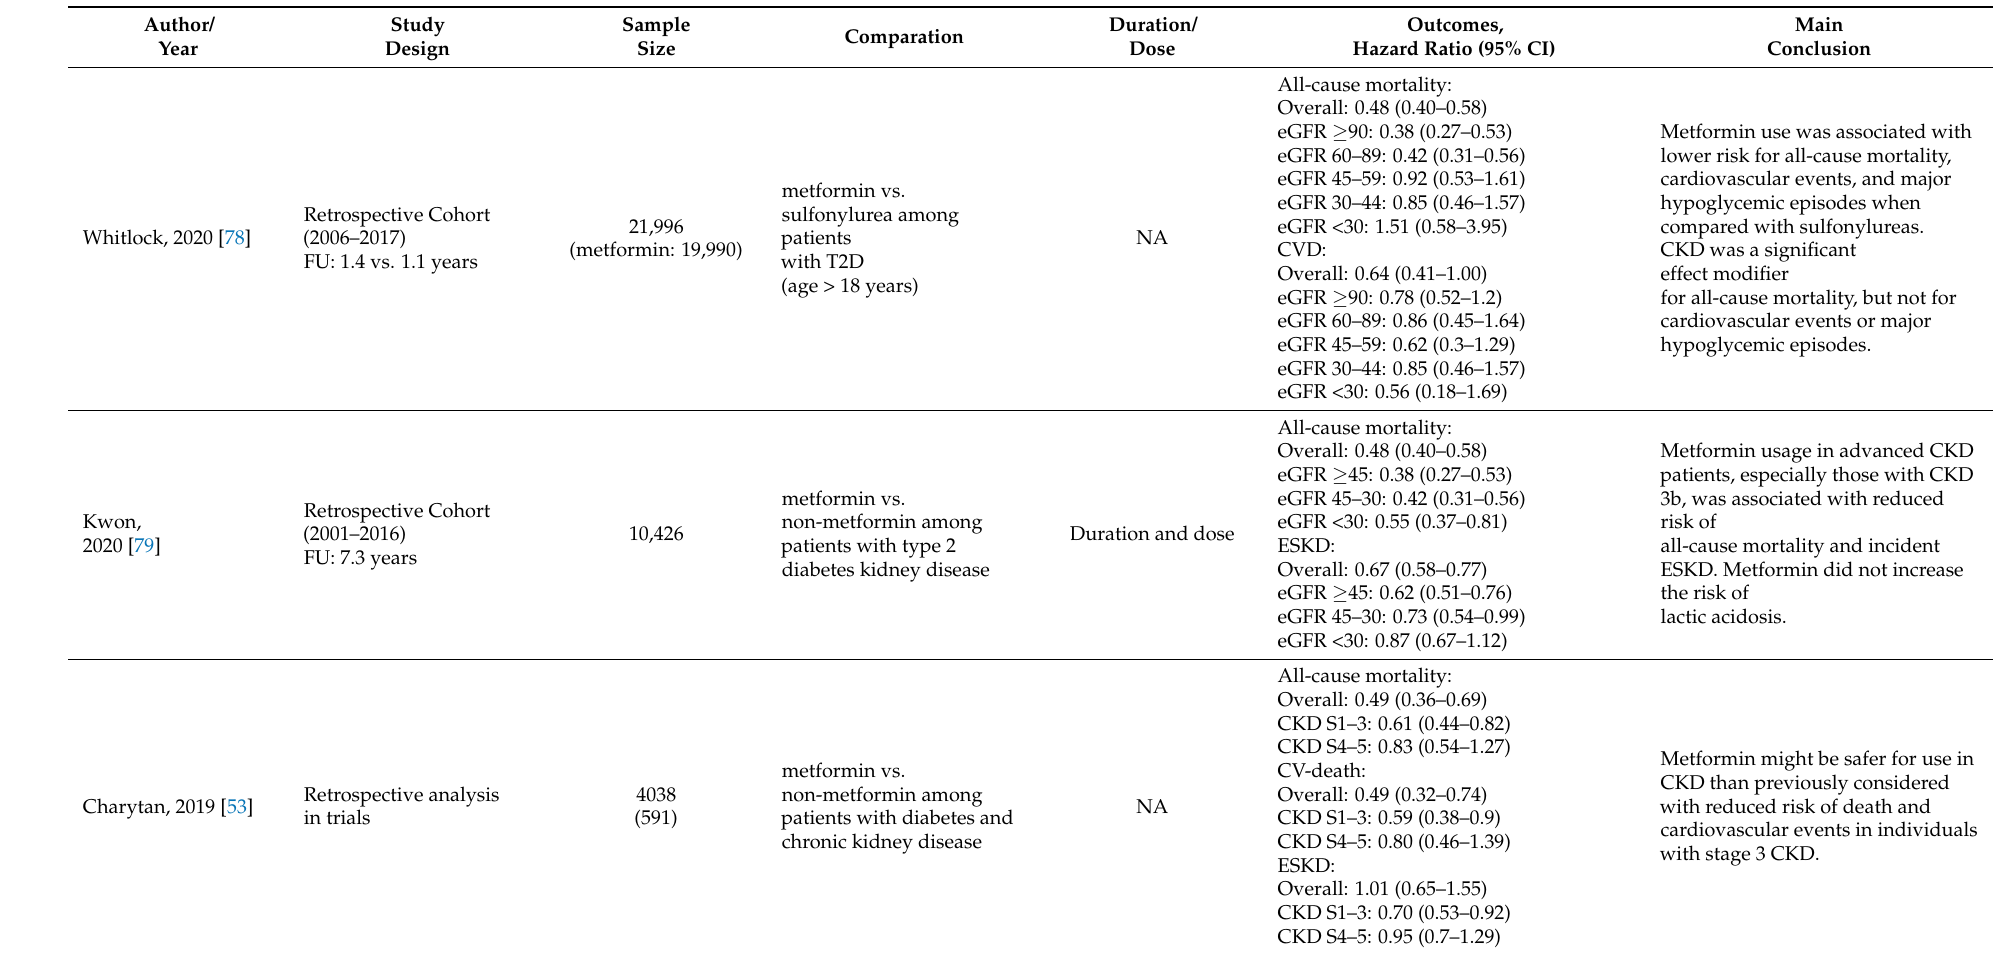
Table 2. Cohort studies on the association of metformin use with cardiovascular–renal outcomes at different CKD